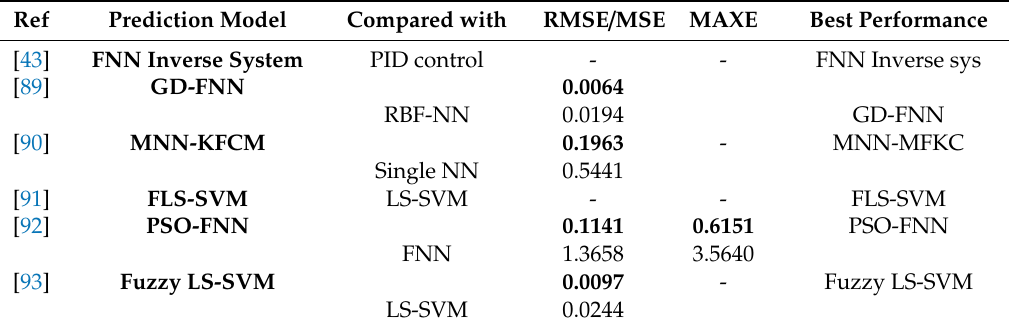
Table 4. Comprehensive analysis of soft sensor models based on fuzzy logic (FL) NN / SVM (for the list of abbreviations see Table